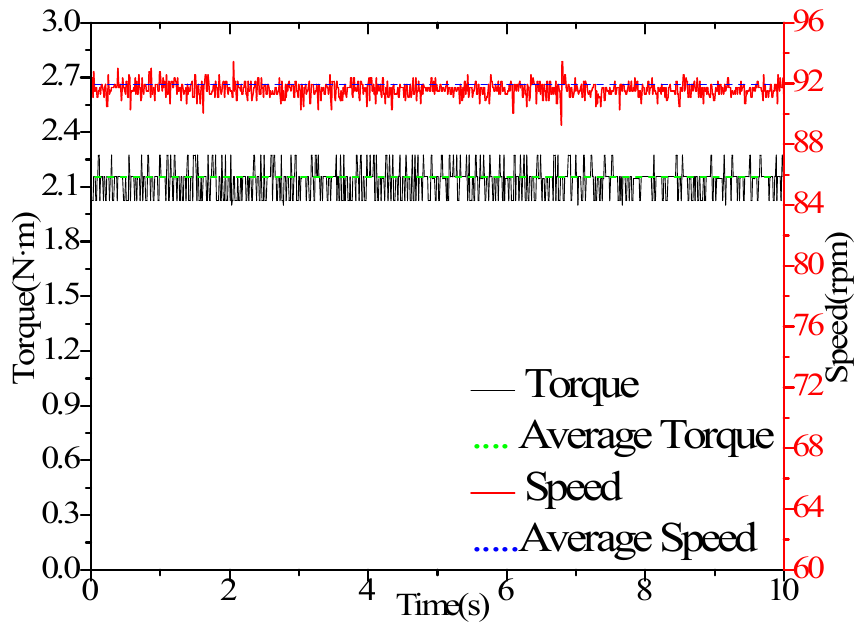
Figure 26. The average output torque and steady-state speed of 1 kW DRPMSM.